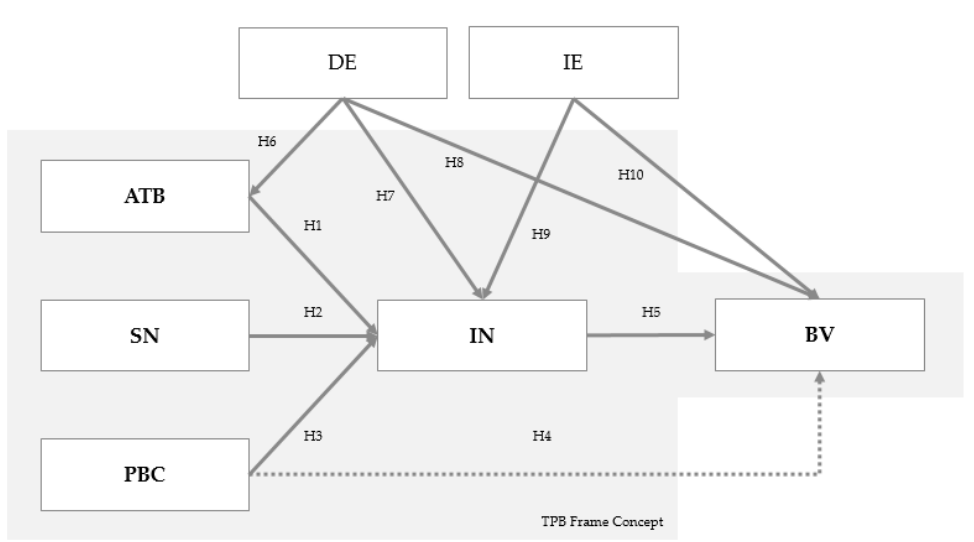
Figure 1. Model used in the partial least squares (PLS) analysis according to Theory of Planned Behavior (TPB). ATB = attitude towards behavior, BV = behavior, DE = direct experience, IE = indirect experience, IN = intention, SN = subjective norm, PBC = perceived behavioral control. Source: Authors’ illustration.